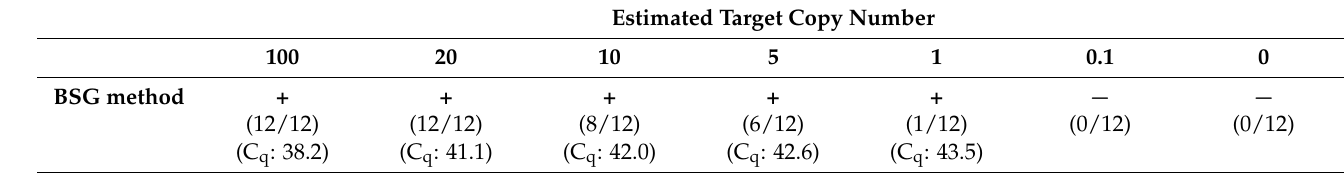
Table 3. Sensitivity assessment of the developed real-time PCR BSG method using a control plasmid carrying one copy of the targeted sequence from B. subtilis . The presence and absence of amplification are symbolized by “+” and “ − “, respectively. For each target copy number, 12 replicates were tested. The number of positive replicates out of the 12 replicates tested is indicated and the means of the observed C q are indicated in brackets.